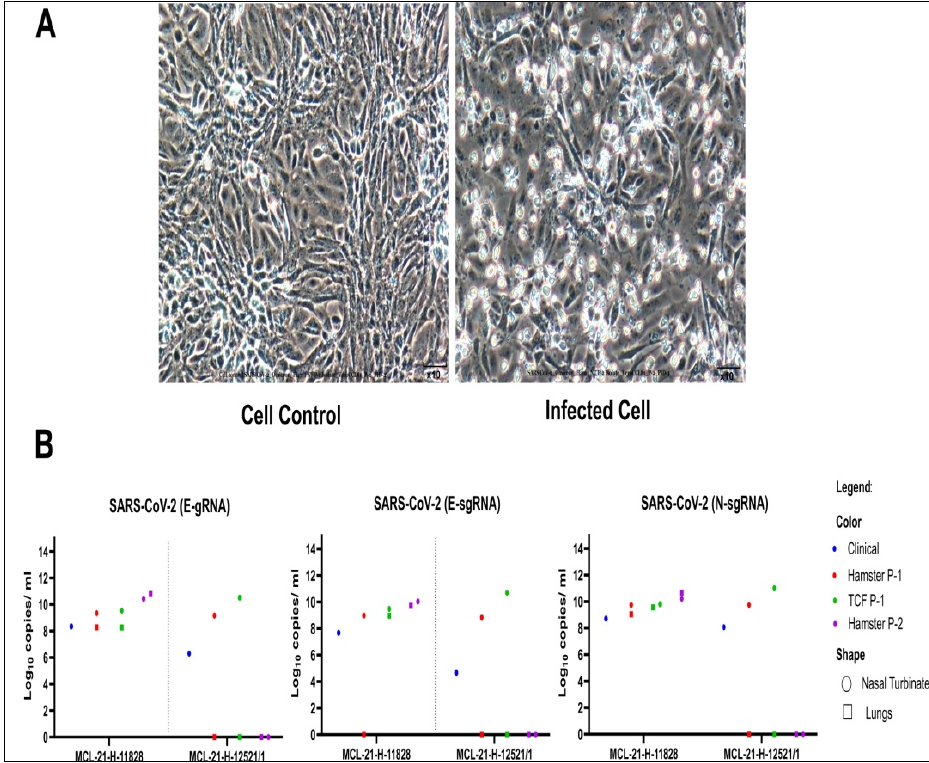
Figure 1. Omicron variant virus isolation in the Vero CCL-81 cells: ( A ) Vero CCL-81 cell control (Left) and Omicron infected Vero CCL-81 cell (Right) at passage 2, PID-4. ( B ) The viral load of the SARS-CoV-2 in human clinical samples, hamster specimens at passage 1 and 2 and Vero CCL-81 at passage 1 culture. The genomic RNA and subgenomic RNA load for the E gene along with N gene from nasal turbinate and lungs of two different clinical specimens.